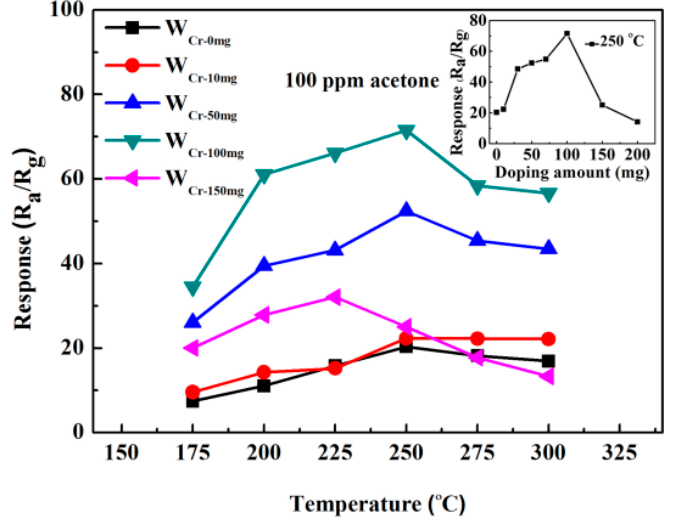
Figure 8. Responses of W Cr-0mg , W Cr-10mg , W Cr-50mg , W Cr-100mg and W Cr-150mg gas sensors as a function of the operating temperature, to 100 ppm acetone. (The inset image is the response of different Cr doping amount gas sensors to 100 ppm ethanol at 250 °C).